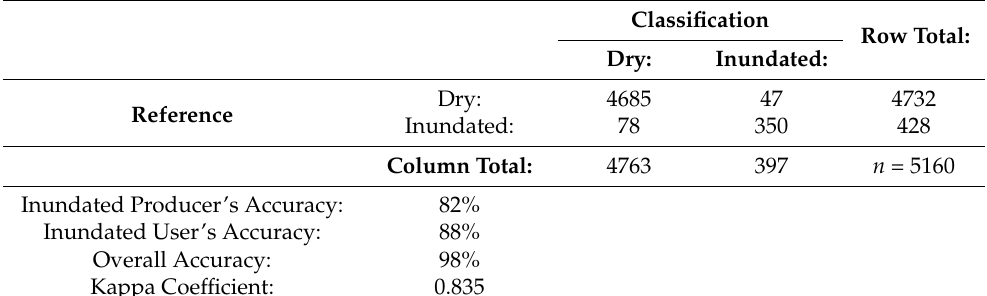
Table 3. The confusion matrix for the LandTrendr model statewide. The performance of the LandTrendr model when compared to manual interpretation of independent satellite imagery. Over- all accuracy is high at 98%, producer’s and user’s accuracies for the inundated class are 82% and 88%, respectively. This suggests good performance of the LandTrendr model in identifying surface water.